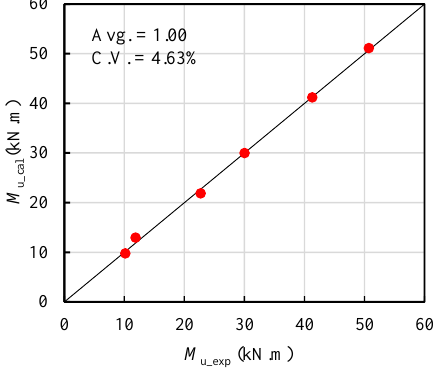
Figure 15. M u_cal versus M u_exp in this study.